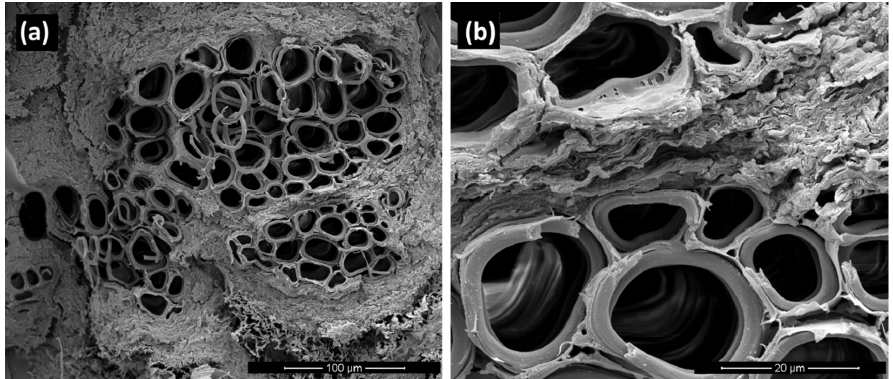
Figure 4. SEM micrographs of the fracture surface of UNID composites at two different magnifications: ( a ) scale bar 100 μ m; ( b ) scale bar 20 μ m.